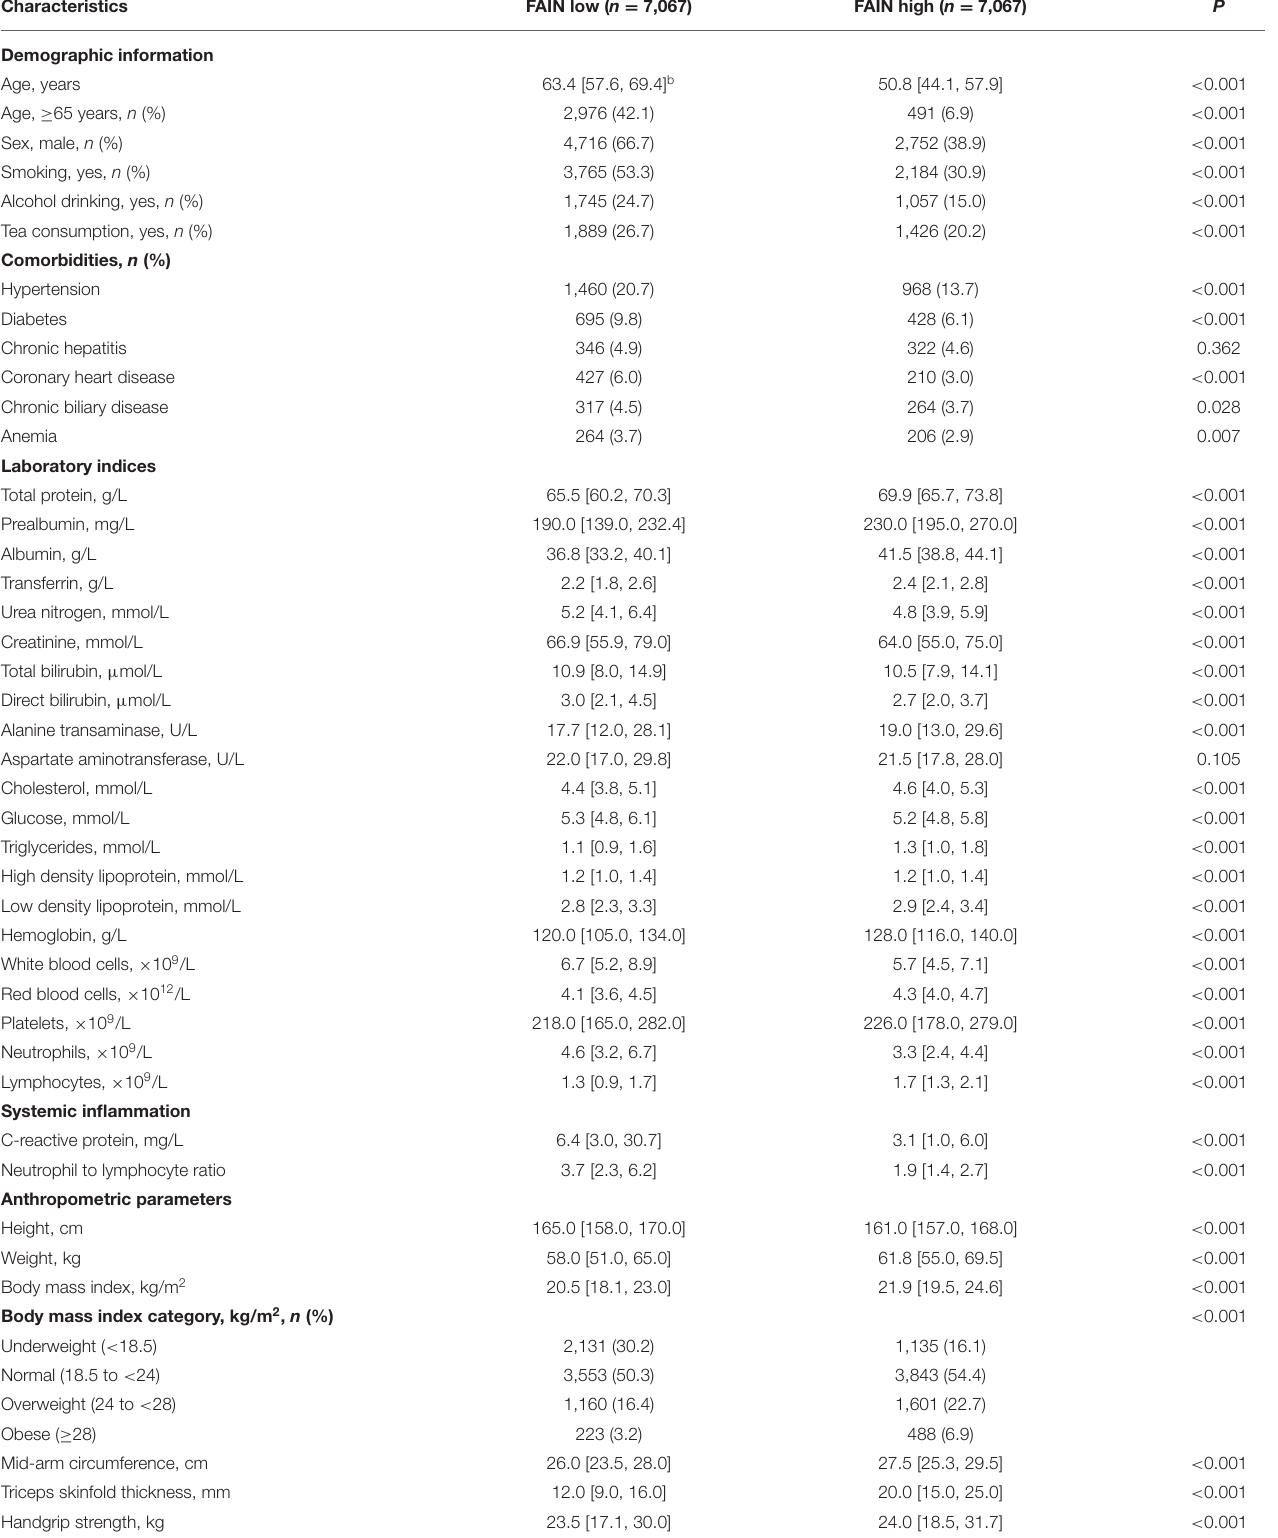
TABLE 2 | Associations between the patient characteristics and median-dichotomized FAIN a .